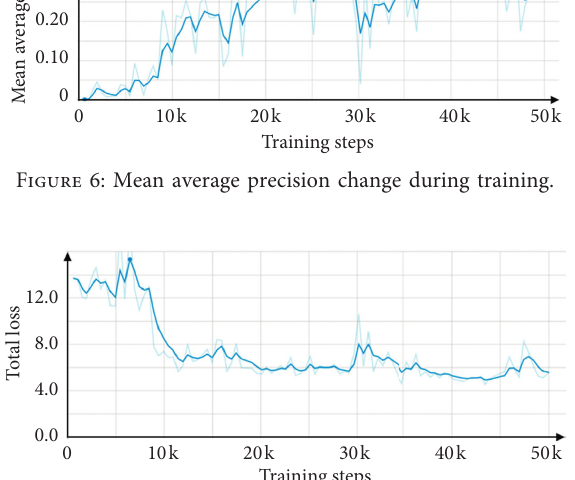
Figure 7: Total loss change during training.